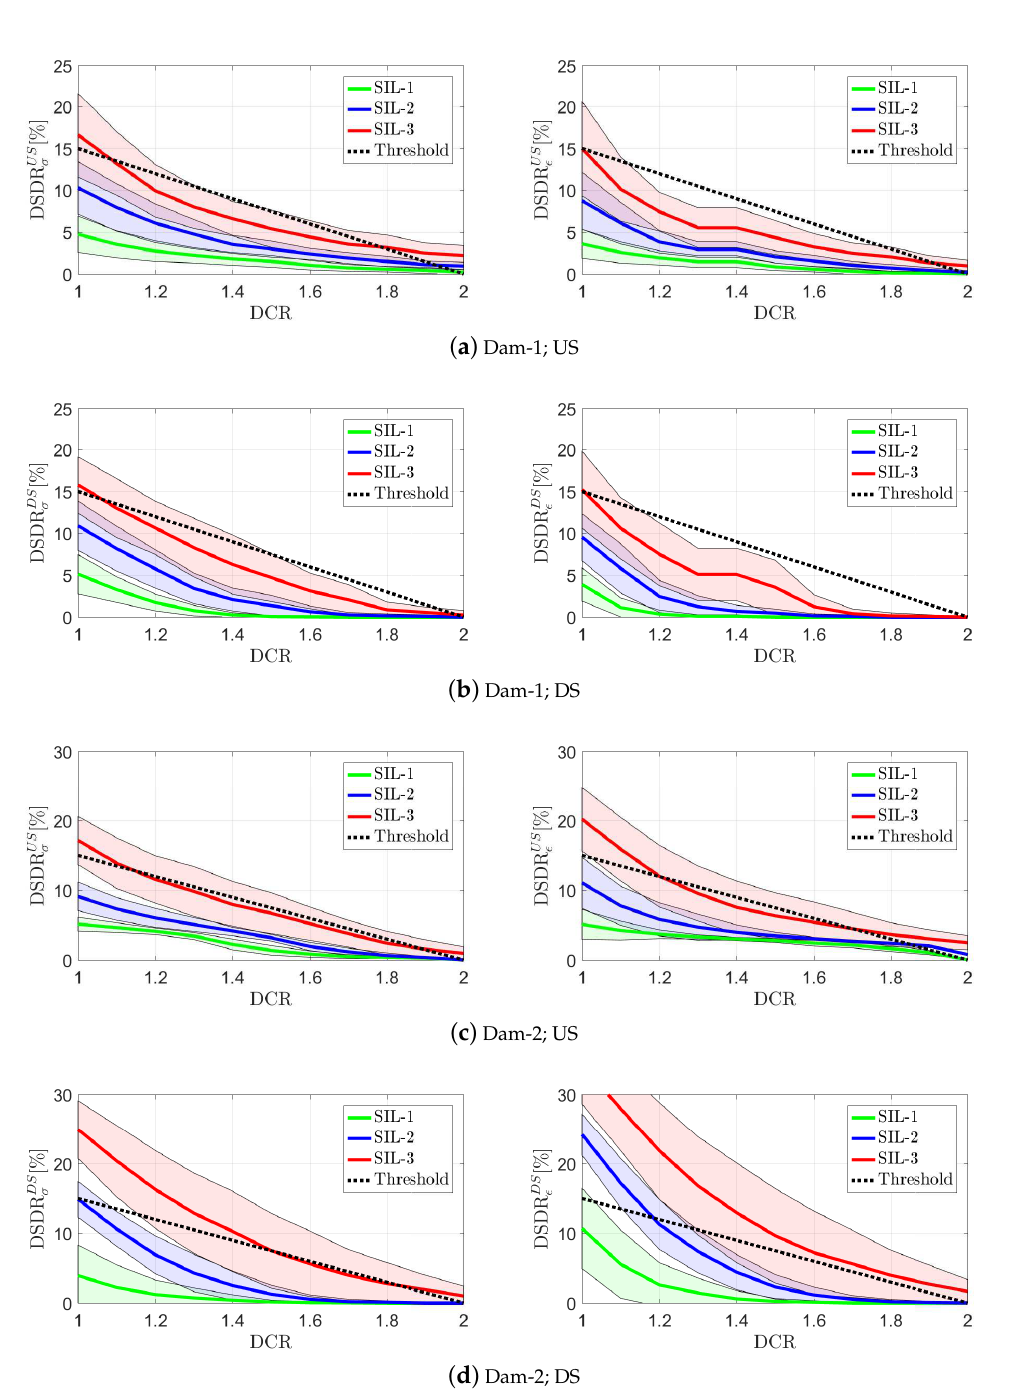
Figure 6. ( a – d ) Damage Spatial Distribution Ratio (DSDR)–DCR of arch dams subjected to three seismic intensity